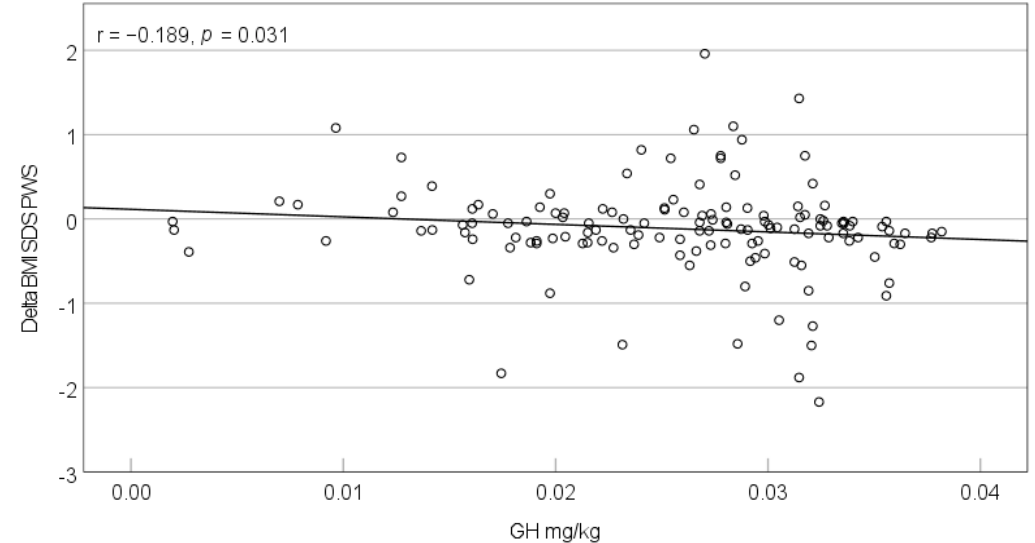
Figure 2. Correlation between the intra-lockdown GH dosage (mg/kg) and change in BMI-SDS PWS during the lockdown period in March–April 2020 in individuals with PWS >2 years.